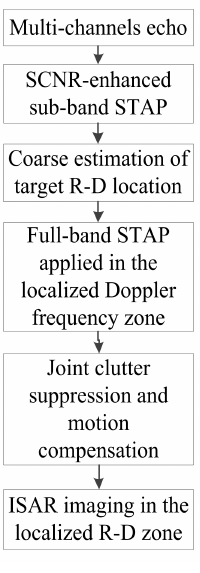
Figure 2. Flowchart of the proposed